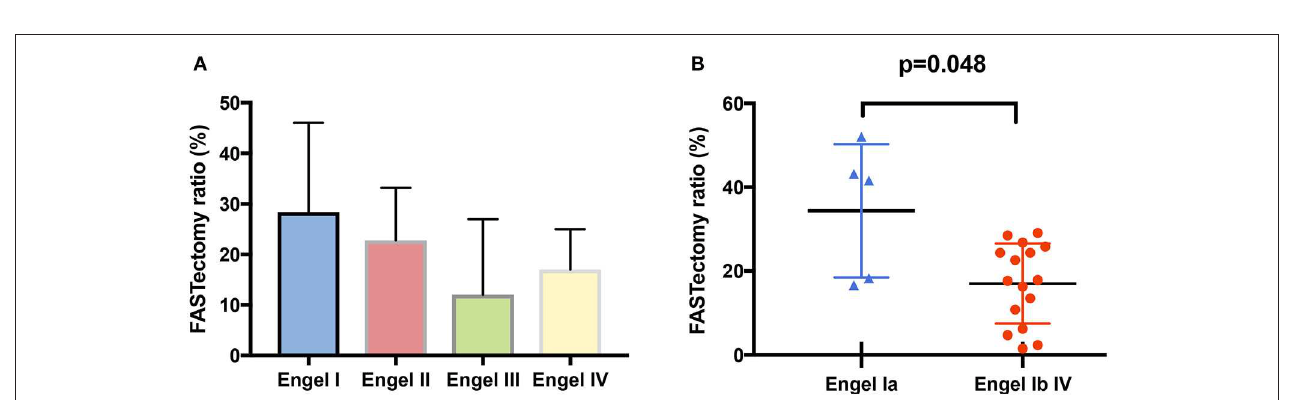
FIGURE 3 | locations (F/F + , frontal/frontal + , T/T + , temporal/temporal + , Pcx, posterior cortex). Mean values of OR, EZ + R, and EZ – R were, respectively 78.3, 33.6, and 74.5% for T/T + patients ( n = 7), 64.8, 29.8, and 43.4% for F/F + patients ( n = 11), and 71.2, 34.4, and 68.7% for Pcx patients ( n = 3). (B) OR, EZ + R, and EZ–R for F/F + and T/T + patients only. (C) OR, EZ + R, and EZ – R in MRI + ( n = 13) or MRI- ( n = 8) patients. Mean values were, respectively 73.6, 35.9, and 67.9 for MRI + patients, and 64.8, 26.3, and 65.2% for MRI- patients. (D) OR, EZ + R, and EZ – R in seizure-free (class Ia, n = 5) and not seizure-free (class Ic to IV n = 16) patients. Mean values of OR, EZ + R, and EZ – R were, respectively 69.0, 34.4, and 61.4% for patients in class Ia, and 69.8, 28.1, and 64.9% for patients in class Ib to IV.